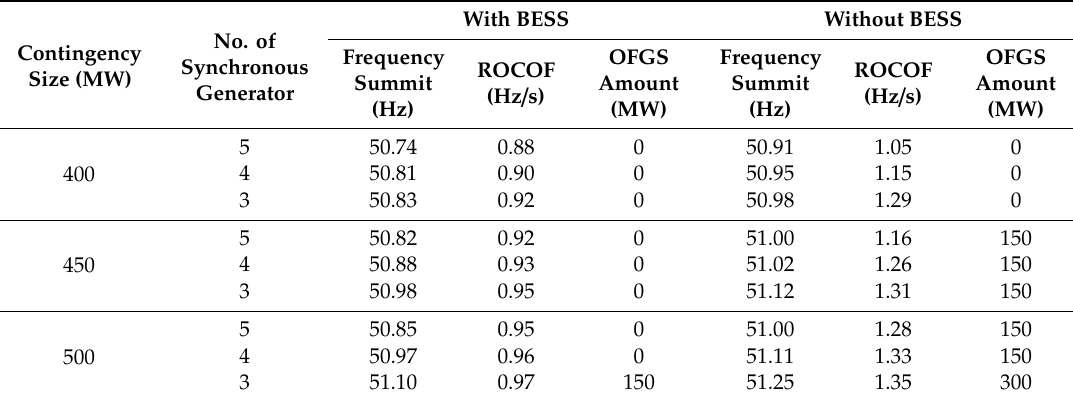
Table 5. Summary of system